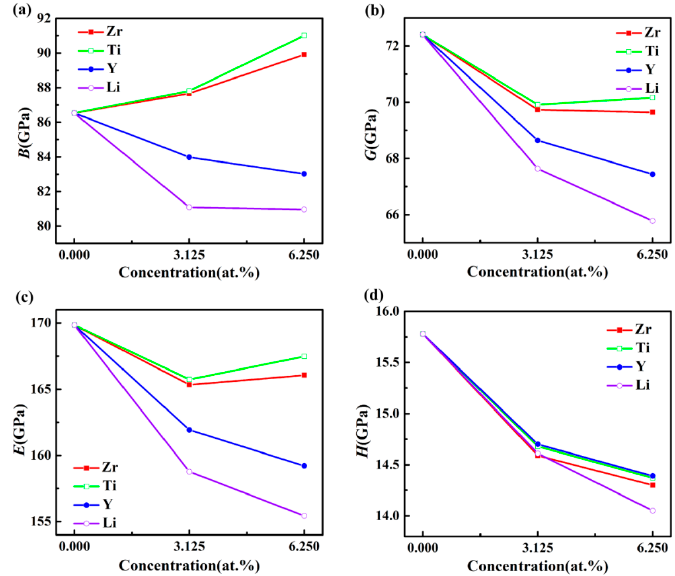
Figure 3. The elastic moduli B ( a ), G ( b ), E ( c ), and hardness H (GPa), ( d ) of L1 2 –Al 3 Sc doped with element M (M = Zr, Ti, Y, and Li), as a function of the doping concentration. Furthermore, the doped Al-Sc-M compounds displayed lower G and E , meaning that the shear strain resistance and stiffness were reduced. In addition, the E values of Al 3 Sc doped with Zr and Ti were increased, when the doping concentrations increased from 3.125% to 6.25%, indicating that the higher concentration doping showed a better performance for the Al-Sc-M (M = Zr/Ti).